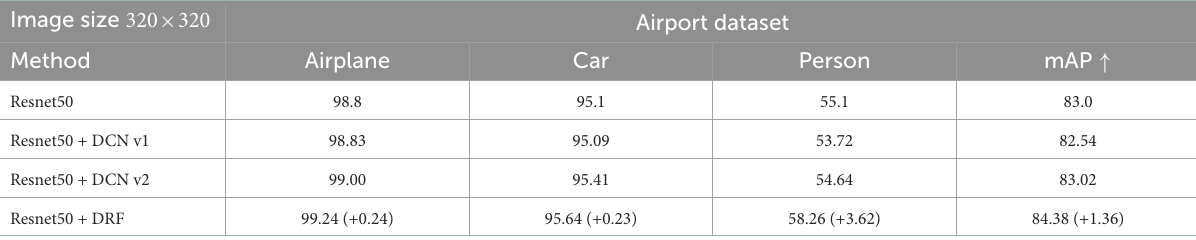
TABLE 8 Detection results on Airport dataset by replacing the penultimate residual block of the last stage of Resnet50 with the proposed DRF, DCN v1 (Dai et al., 2017), and DCN v2 (Zhu et al., 2019) for comparison. Image size 320 320 ×